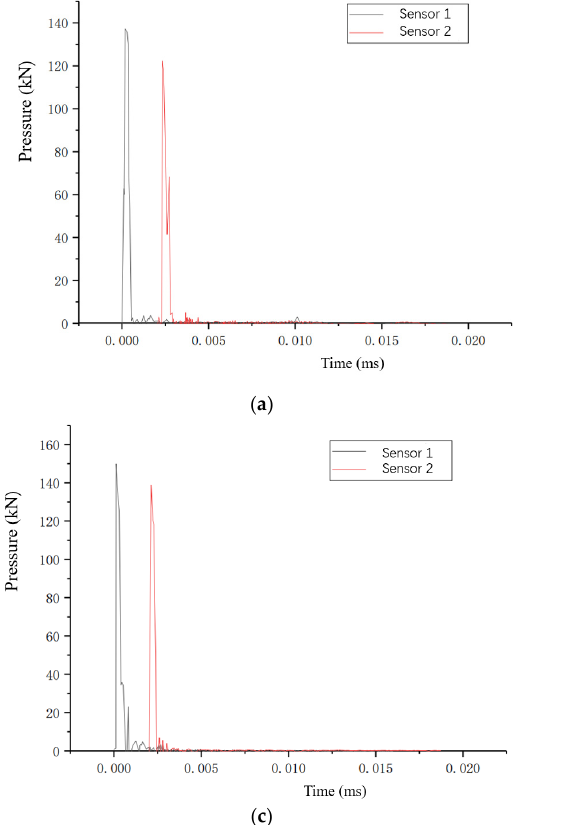
Table 3. Experimental results of plane explosion wave of spindle specimens with different steel fiber content.